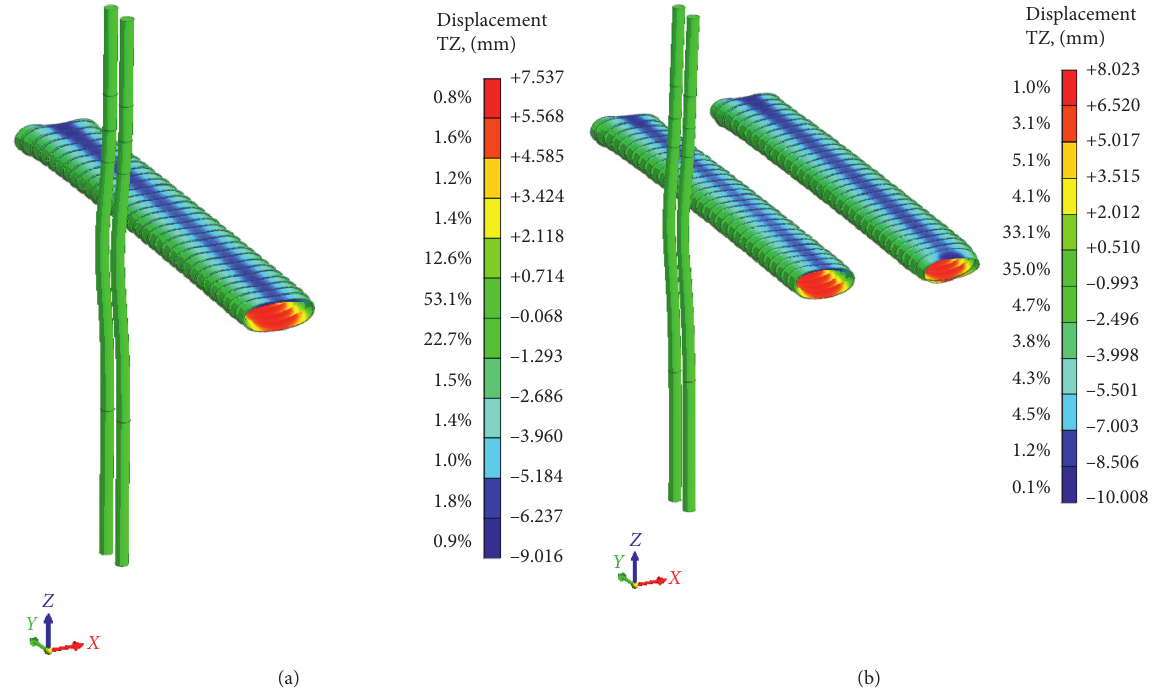
Figure 14: Vertical displacement of pile and tunnel in condition (b). (a) Left line finished. (b) Right line finished.